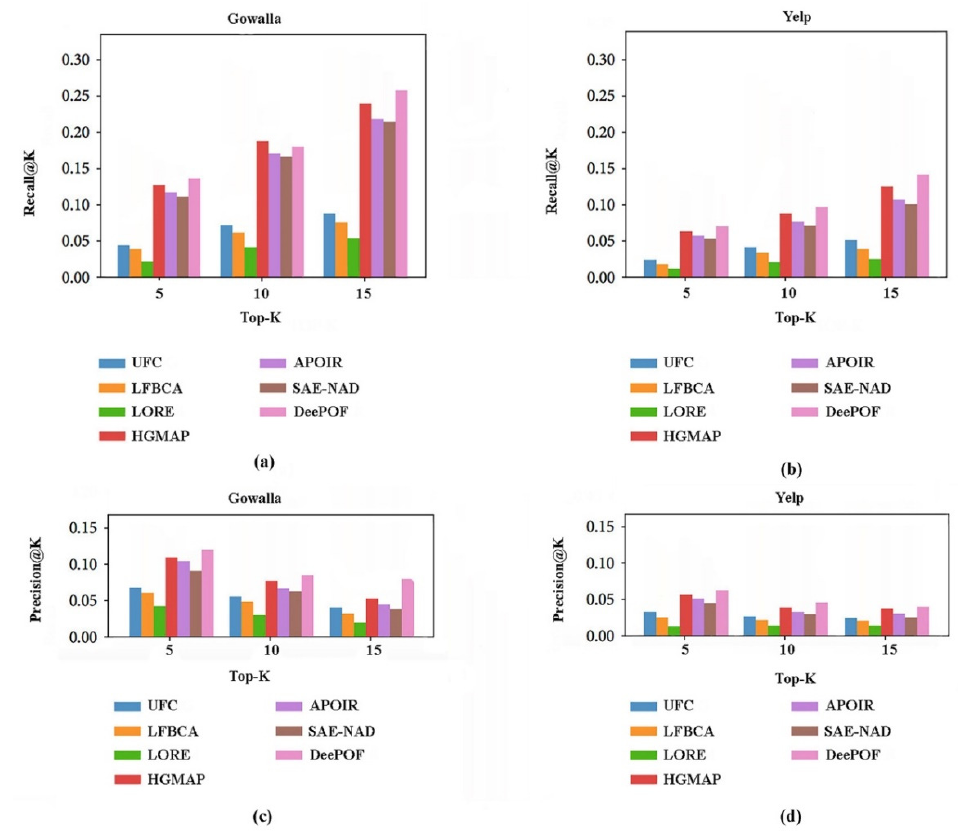
Figure 7. DeePOF [148] compared to 6 other models on the Gowalla and Yelp datasets. ( a ) Recall on the Gowalla. ( b ) Recall on the Yelp. ( c ) Precision on the Gowalla. ( d ) Precision on the Yelp.